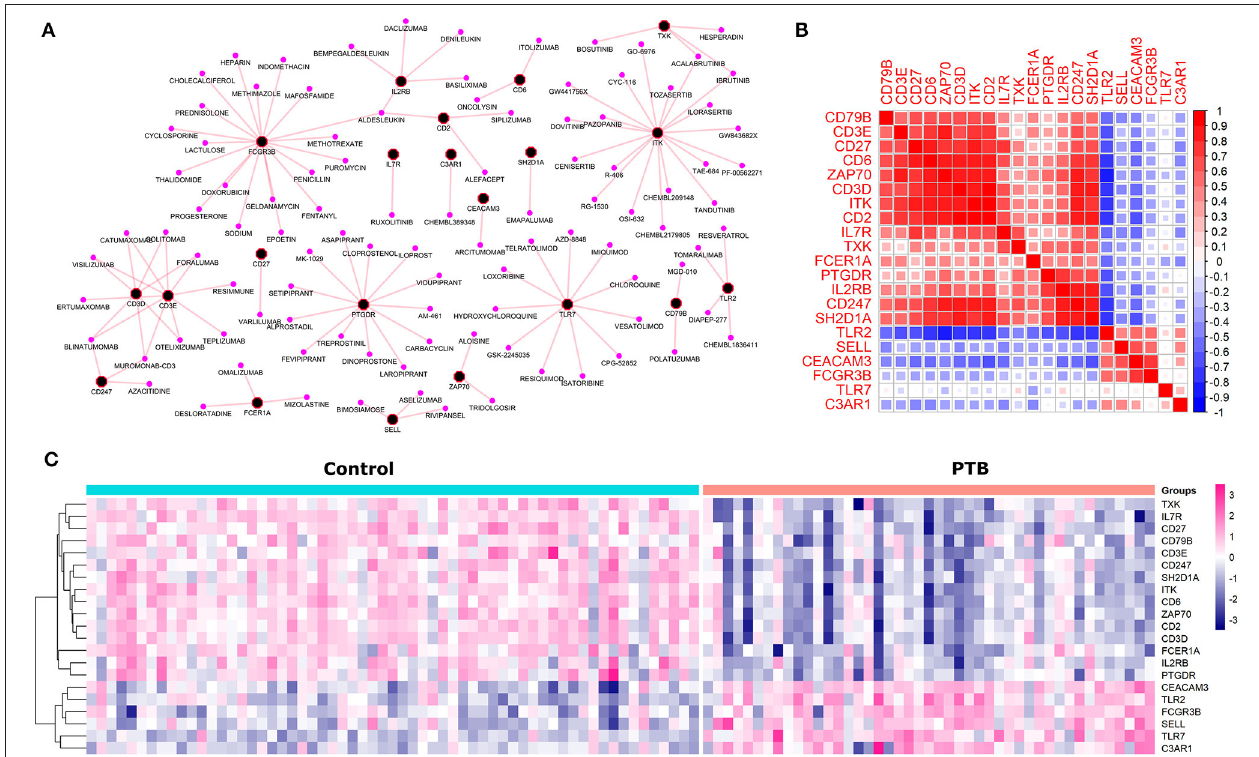
FIGURE 4 | The druggable targets with their expression, interaction and co-expression (A) The network depicts the drug-target interaction where black and pink nodes represent target and drugs respectively. (B) The co-expression (a similar pattern of gene expression) among the druggable genes where red and blue represent the positive and negative correlation. (C) The pattern of gene expression of druggable genes in control and PTB patient samples clearly depicts a distinction between the control and PTB groups.